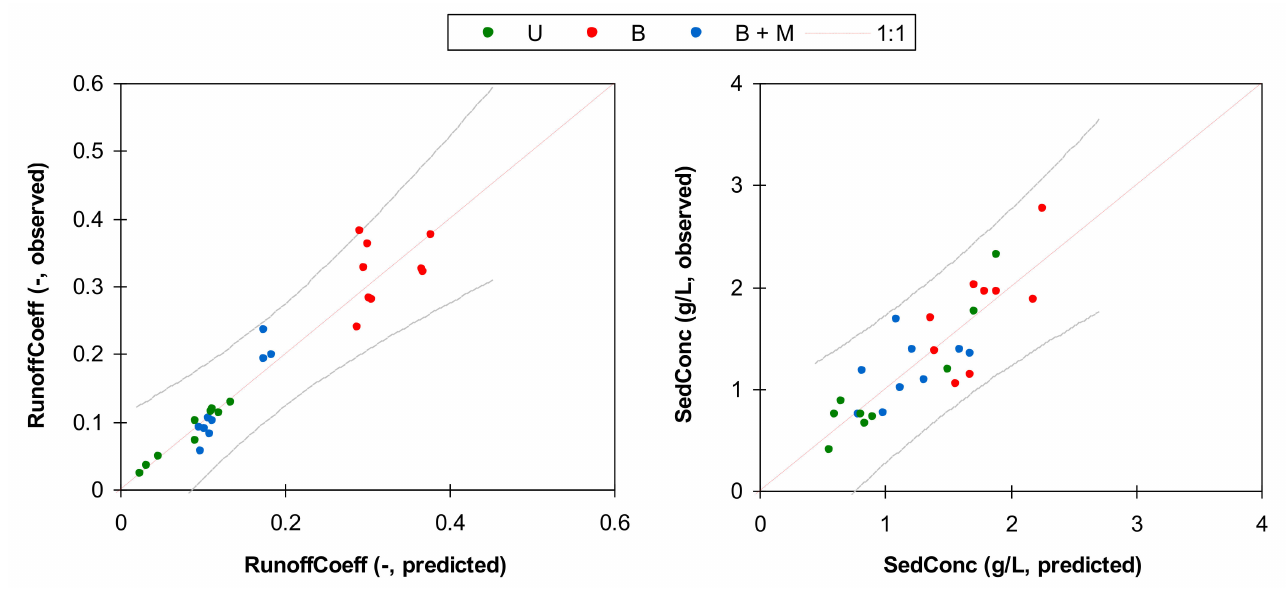
Figure 5. Scatter plots of observations against predictions by regression models applied to runoff coefficients (RunoffCoeff, left ) and sediment concentrations (SedConc, right ) in the experimental sites immediately after the prescribed fire and mulching treatment (Samo, Calabria, Southern Italy). The gray lines are the 95%-confidence interval. Legend: B = burned and not treated; M = burned and mulched. Table 5. Statistics and indexes to evaluate the prediction capacity of regression models in the experimental sites immediately after the prescribed fire and mulching treatment (Samo, Calabria, Southern